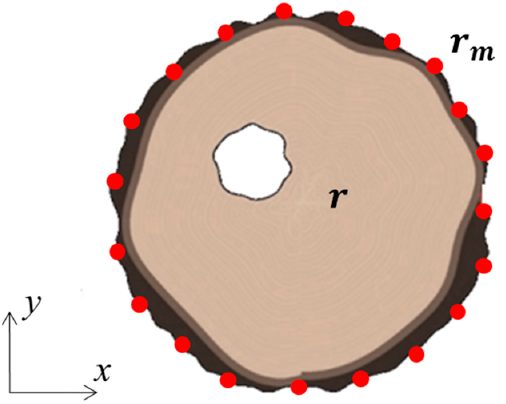
Figure 1. Geometry of a tree cross-section with an arbitrary shape. The red circles represent the Ground Penetrating Radar (GPR) measurement points along the outer surface of the bark; the white object is a randomly-positioned target within the cross-section.